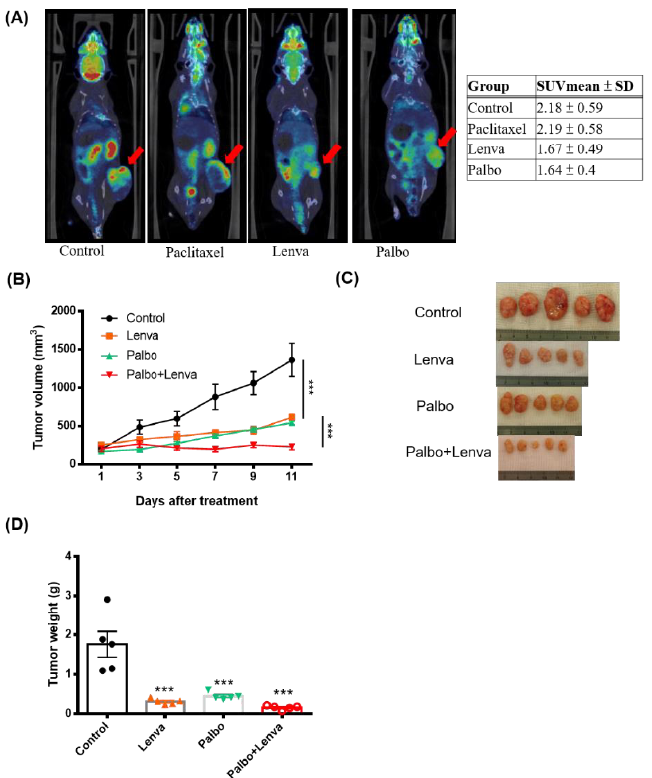
Figure 3. Identification of druggable molecular targets in PDX-mLung. PDX-mLung mice were randomized ( n = 5 per group) to receive the fibroblast growth factor receptor inhibitor lenvatinib alone (10 mg/kg given orally five days per week), the cell cycle inhibitor palbociclib alone (100 mg/kg given orally five days per week), and a combination of lenvatinib (5 mg/kg given orally five days per week) and palbociclib (50 mg/kg given orally five days per week). Control animals were left untreated. ( A )Whole-body 18 F-FDG PET imaging was used to monitor tumor growth by calculating mean standardized uptake values (SUVmean), ( B ) tumor volume, ( C ) gross tumors, and ( D ) tumor weight. *** p < 0.0001.